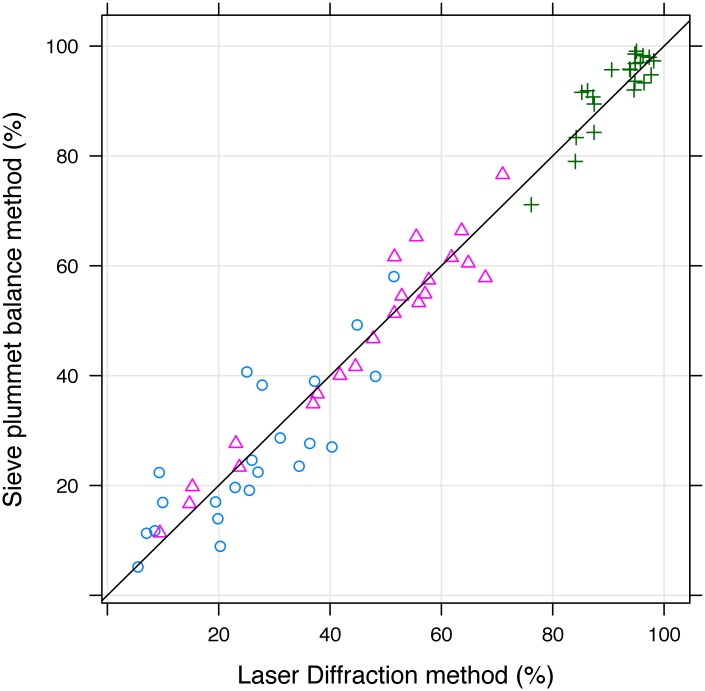
Scatter plot of cumulative particle size (%) using sieve plummet balance (SPM) and laser diffraction (LDM).Results for LDM are NP. Blue circles correspond to coordinates for LDM < 9μm (x-axis), SPM < 2μm (y-axis); red triangles for LDM < 30μm, SPM < 20μm; and green crosses for LDM < 280μm, SPM<200μm.